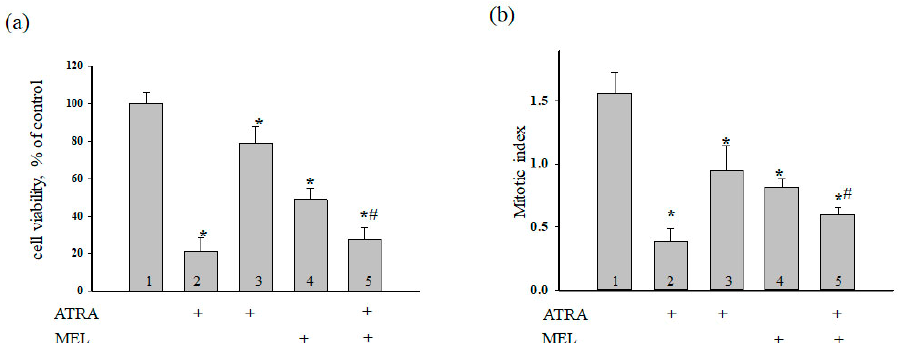
Figure 2. Combined effect of MEL and ATRA on the viability and proliferation status of HL-60 cells. Cells were seeded in a 96-well plate at a density of 5 × 10 3 cells per well and treated with 1 μ M ATRA (column 2), and 10 nM ATRA (columns 3) and 1 mM MEL (column 4), and MEL in combination with 10 nM ATRA (column 5); untreated cells (control, column 1). ( a ) Cell viability in % relative to the control; ( b ) The mitotic index (MI) is defined as the ratio between the number of cells in mitosis and the total number of cells. The data are presented as the means ± S.D. of ten separate experiments. * p < 0.05 significant difference in values in comparison with the corresponding control, # p < 0.05 significant difference in values compared to the value obtained after the addition of MEL alone.